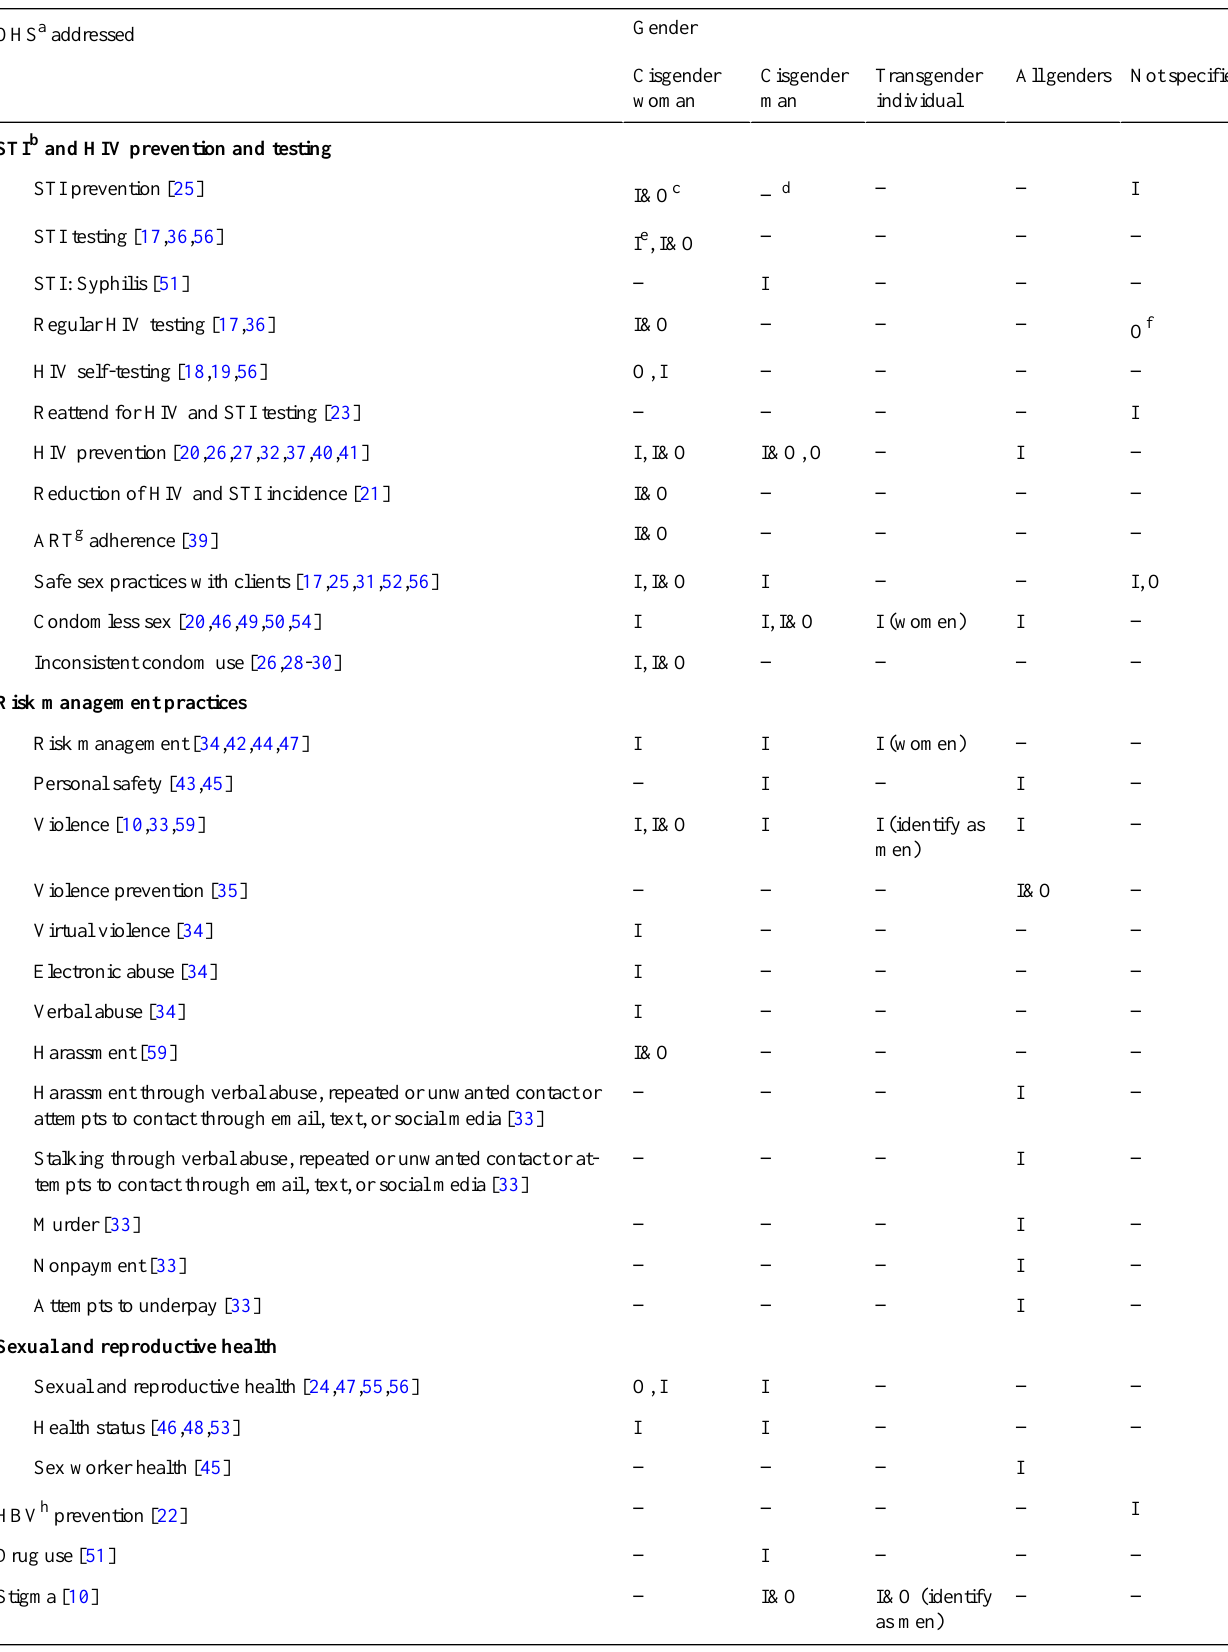
Table 1. Occupational health and safety concerns for indoor, outdoor, and indoor and outdoor sex workers. GenderOHS a